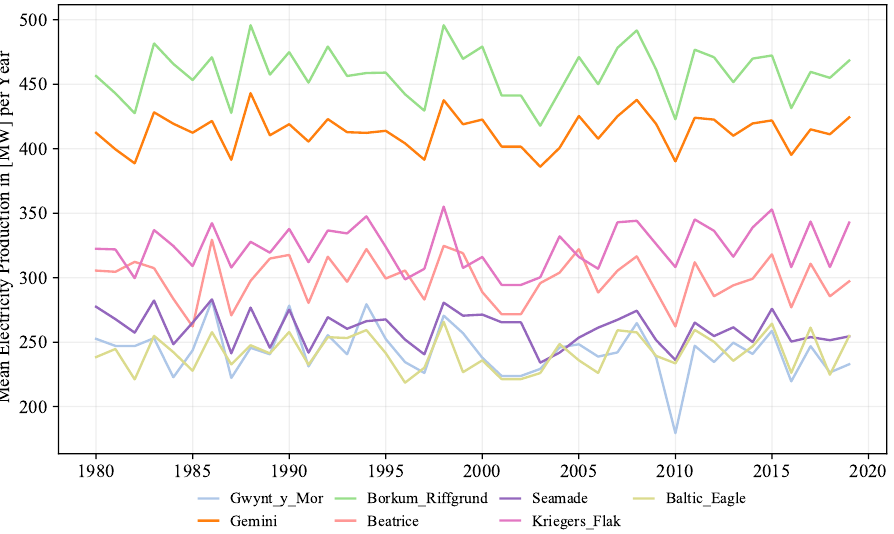
Figure A2. Mean production of selected wind farms from 1980 to 2019. Every line illustrates the yearly mean production of one wind